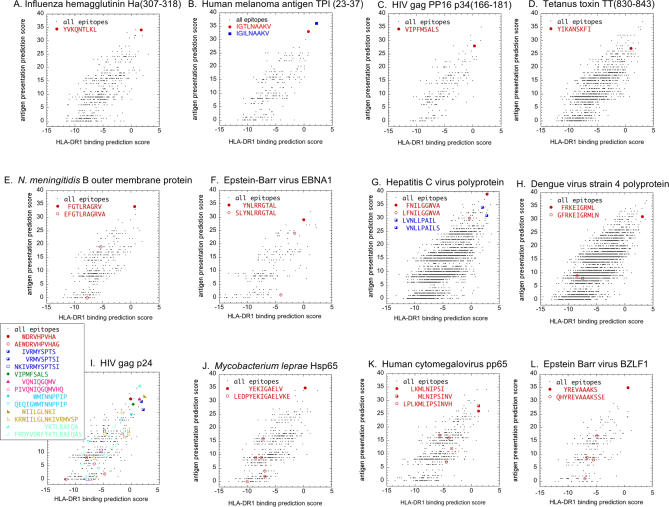
Predicted Binding and Antigen Presentation Scores for Known HLA-DR1-Restricted T Cell Epitopes(A–D) T cell epitopes for which the MHC-binding register has been definitively established. Filled circles (red) show 9-mer binding frames established by crystallographic analysis or truncation and alanine scanning mutagenesis, black dots indicate all possible 9-mer epitopes present in the entire proteins.(A–C) Binding frame identified by crystallographic analysis.(A) HA(306–318) from influenza virus heamagglutinin (A/New AYork/383/2004(H3N2)) [47]; (B) mutated TPI(23–37) from human triose phophate isomerase containing Ile instead of Thr at position 28 [77,78], with filled blue square indicating mutated peptide recognized as a tumor antigen; (C) PP16 p24(161–181) from HIV-1 strain NY-5 gag p24 protein; (D) TT(830–843) from tetanus toxin [46]; (E–H) T cell epitopes identified by overlapping peptides for which a small minimal peptide epitope has been characterized by truncation analysis. For each minimal peptide epitope, all of the possible 9-mer binding frames are shown as open circles, with the likely MHC binding frame, identified as a 9-residue sequence starting with a hydrophobic residue near the N-terminus of the peptide [23,38,70], indicated by a filled symbol. (E) N. meningitidis outer membrane porin A protein (91–108) [79]; (F) EBV nuclear antigen EBNA-1([78–88) [80]; (G) hepatitis C virus strain LIV23 polyprotein. Two epitopes have been characterized: NS4(1809–1817) and NS4(1879–1888) [81], shown in red circles and in blue squares, respectively. For the NS4 epitope, the minimal 10-mer peptide contains two likely binding frames, indicated by half-filled squares. (H) Dengue virus type 4 virus D4V capsid(84–92) [82]. (I–L) T cell epitopes identified by overlapping peptide analysis with larger minimal peptides. As in (E–H), presumptive binding frames are indicated by solid symbols with other potential epitopes from the same minimal peptide shown with open symbols. (I) HIV-1 (strain HXB2) p24 gag epitopes: AEWDRVHPVHAG(210–221) [83] in red circles; NKIVRMYSPTSI(271–282) [83] in blue squares, as in (G) two possible binding frames are indicated with half-filled squares; HIV-1 (strain NY5) p24 gag epitope PEVIPMFSALSEGATP(167–182) in green diamonds [84], for this epitope the binding frame is known exactly as shown in (C); PIVQNIQGQMVHQ(133–145) in magenta up-facing triangles; QEQIGMTNNPPIP(244–256) [83] in cyan down-facing triangles; KRWIILGLNKIVRMVSP(264–280) [85,86] in brown left-facing triangles; FRDYVDRFYTLRAEQAS(294–311) in aquamarine right-facing triangles [86,87]. (J) Mycobacterium leprae heat shock protein hsp65(61–75) [88]. (K) Human cytomegalovirus (strain AD169) pp65(115–127) [89], as above with two potential binding frames shown in half-filled symbols, (L), EBV BZLF-1 protein(198–210) [90,91].